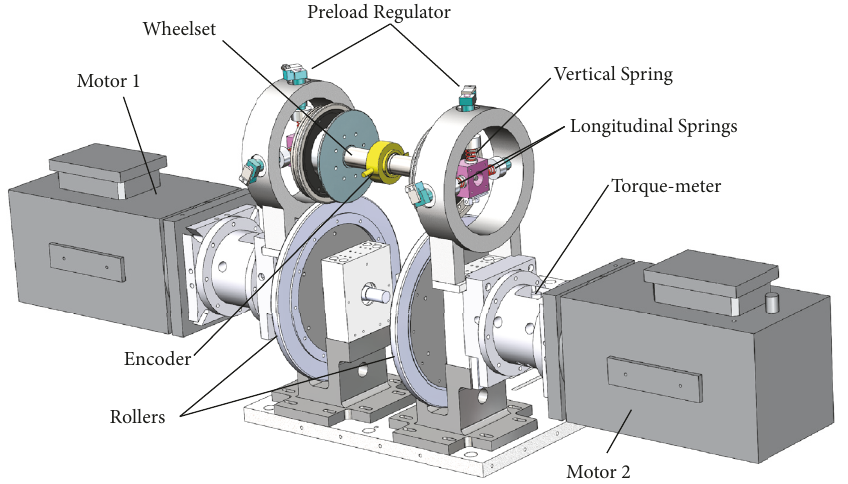
Figure 2: Motors and sensors disposition on the